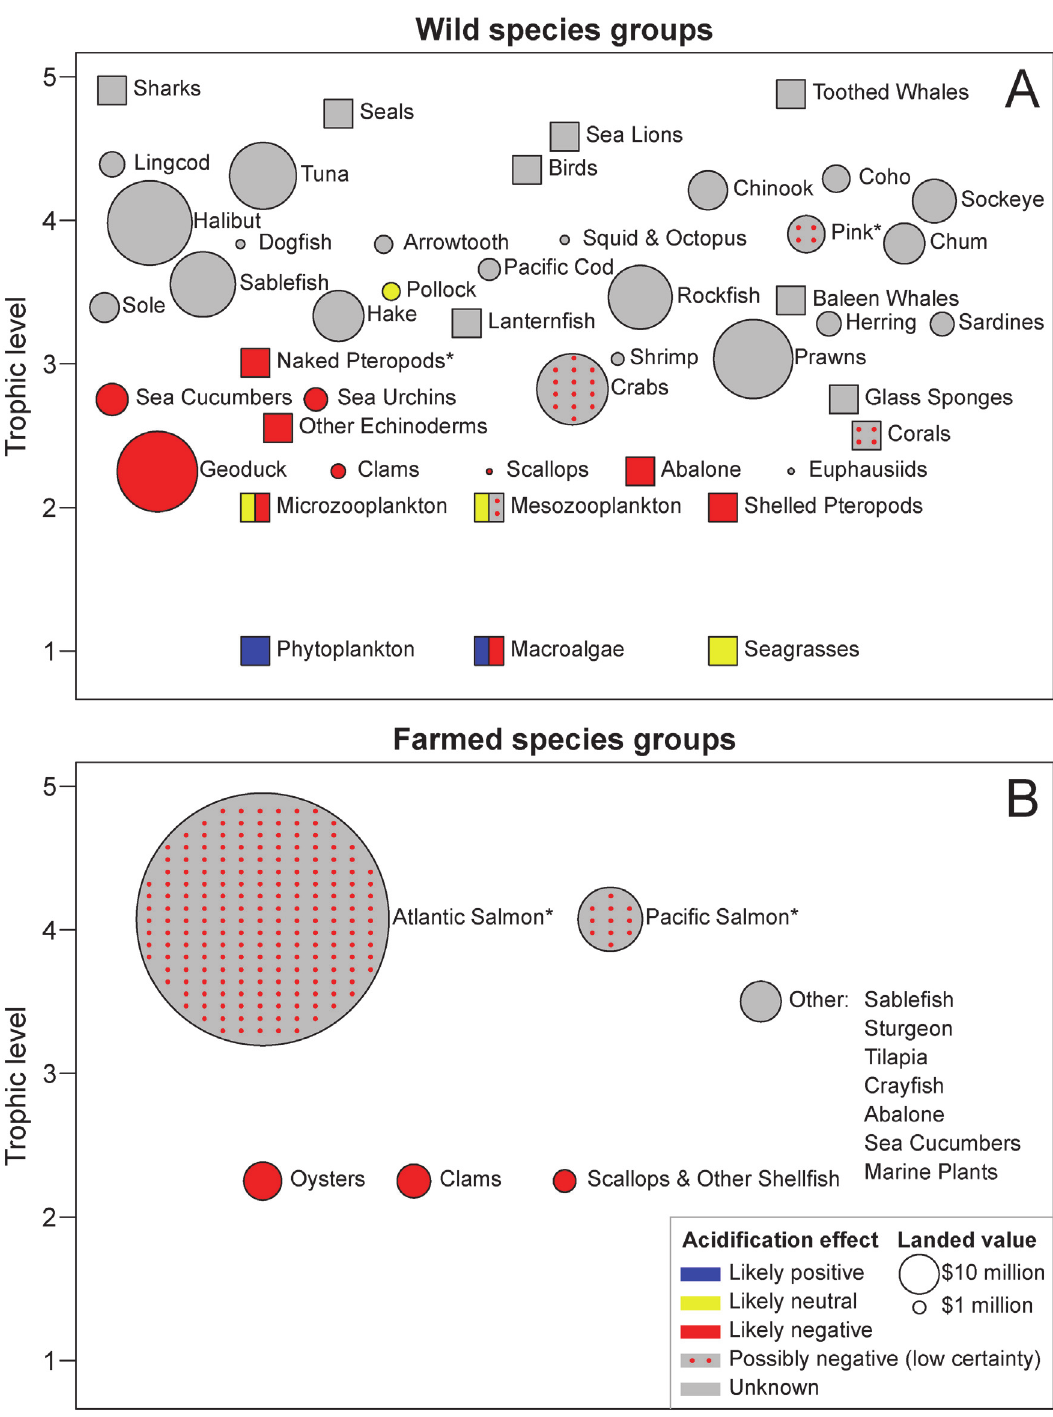
Fig 4. Summary of ocean acidification effects on (A) wild, and (B) farmed species groups in BC waters, including landed value for those that are fished or farmed. Species groups are arranged vertically by trophic level, adapted from output by Preikshot [38] (courtesy of D. Preikshot, Madrone Environmental Services, Duncan BC). Areas of circles are proportional to the landed values in 2011, based on data in [34] (and [39] for euphausiids). Squares represent species groups that are not commercially harvested. Solid colours represent the likely direct effects of ocean acidification (see Results for explanations). Stippling refers to possible effects. For species marked by an asterisk ( * ), colours represent indirect effects. Data and R code for this figure are provided as Supporting Information (S4 Code).